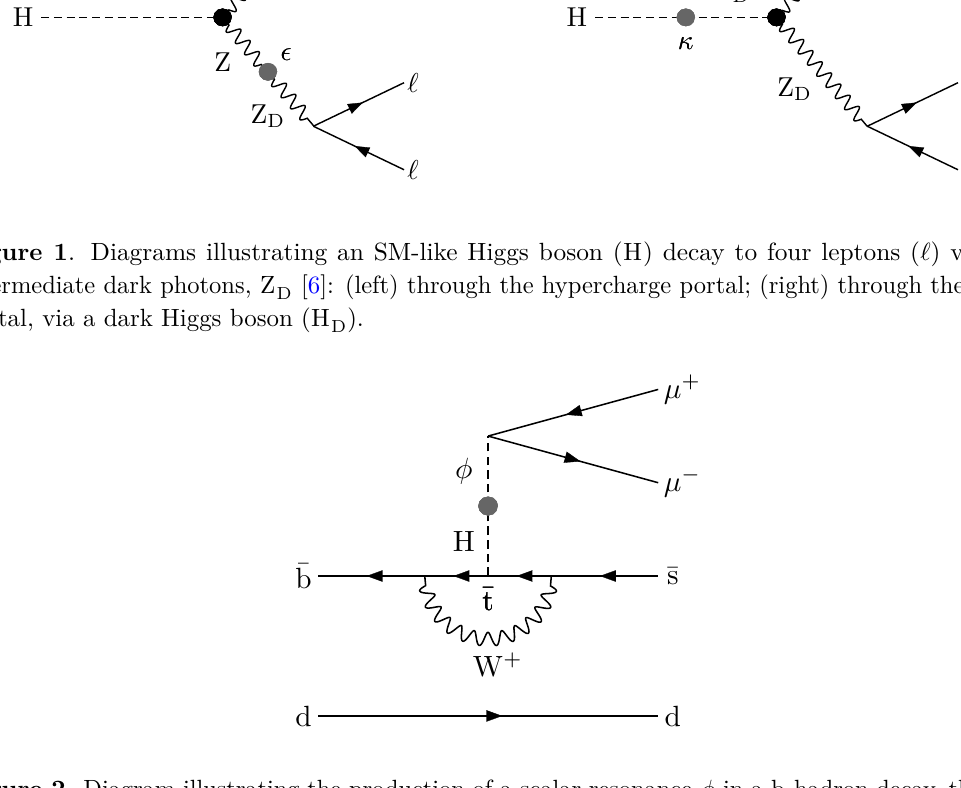
Figure 2 . Diagram illustrating the production of a scalar resonance φ in a b hadron decay, through mixing with an SM-like Higgs boson ( H